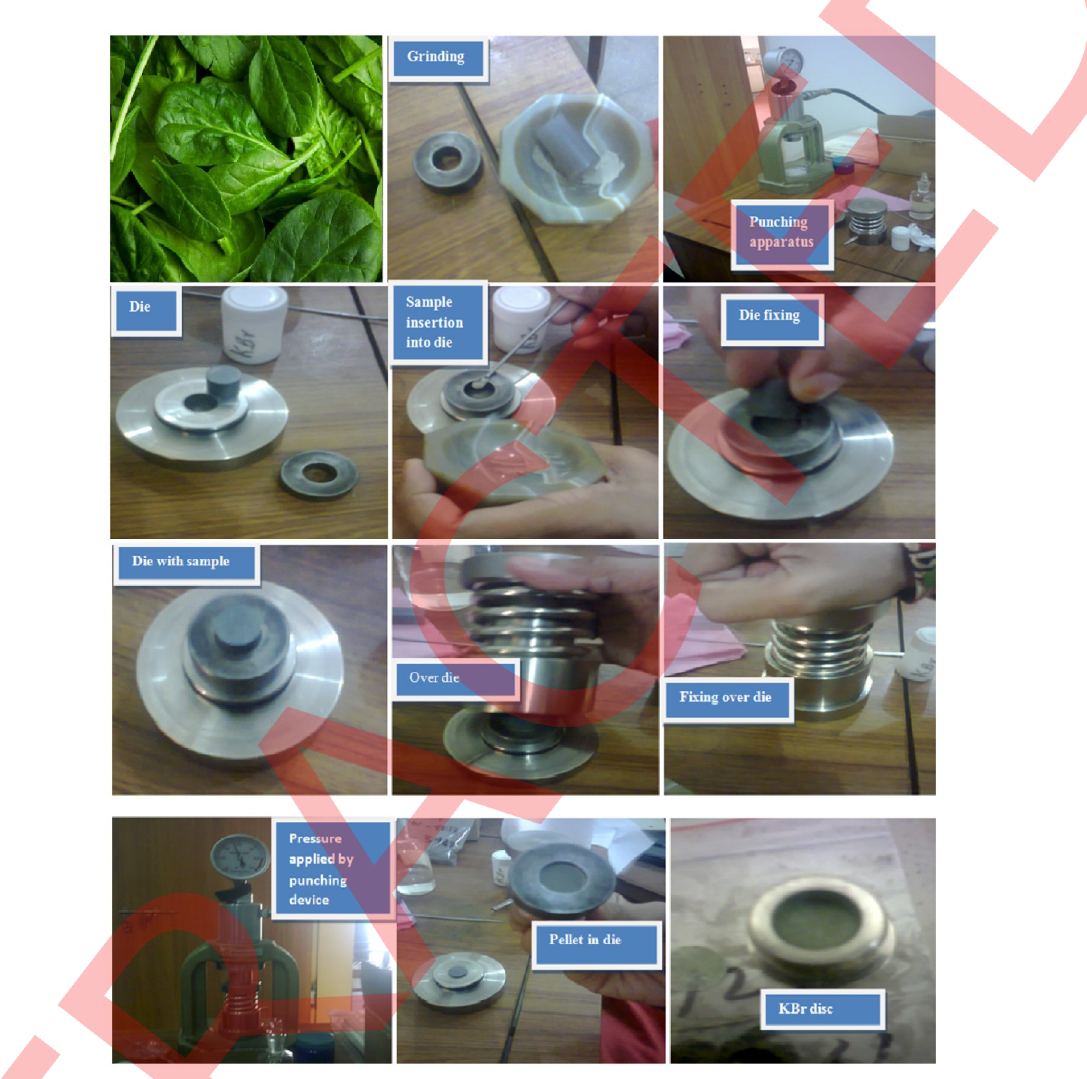
Fig 1. Procedure of Fourier Transform Infrared Spectroscopy usage for analysis of samples. Each subsection picture is showing the step involved in the analysis.